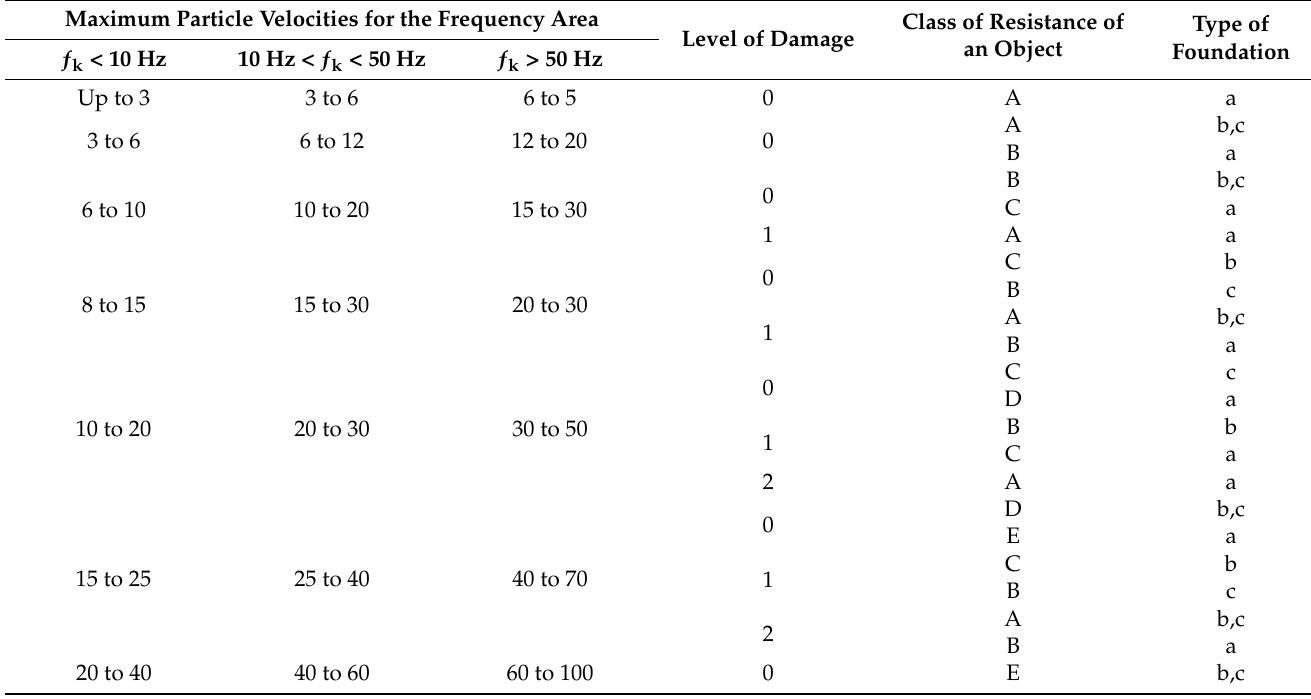
Table 3. Table Dependence of the damage level on maximum particle velocity, type of the structure and foundation soil according to STN EN 1998-1/NA/Z1 [51]. Maximum Particle Velocities for the Frequency Area